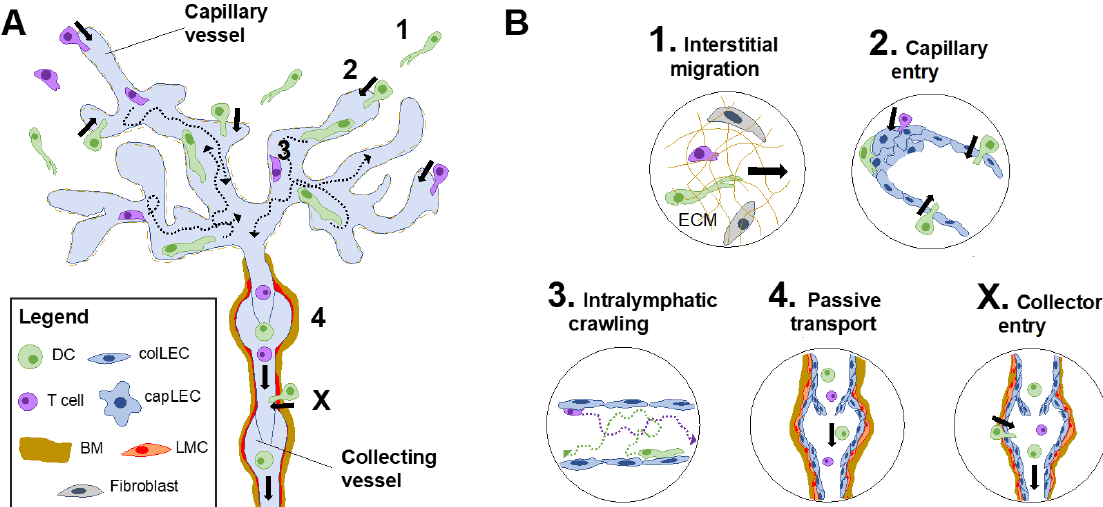
Figure 3. Leukocyte migration through afferent lymphatics occurs in a step-wise manner. ( A ) Summary of the key steps in DC and T cell migration from peripheral tissues through afferent LVs. ( B ) Description of the individual steps. Step 1: Interstitial migration: The interstitial space is comprised of fibroblasts and extracellular matrix (ECM) through which DC and T cells migrate in an ameboid fashion towards initial lymphatic capillaries. Step 2: Capillary entry: Attracted by the peri-lymphatic CCL21 chemokine gradient, DCs and T cells approach blind-ended capillaries and enter through specialized flaps formed by discontinuously joint capillary LECs (capLECs). Step 3 : Intralymphatic crawling: DCs and T cells actively crawl and patrol within the capillary lumen, thereby interacting with the lymphatic endothelium. Step 4: Passive transport: migratory DCs and T cells eventually reach the downstream collecting vessels segments. Here, lymph flow increases due to vessel contractions mediated by the collector-surrounding lymphatic muscle cells (LMCs), leading to the detachment of leukocytes and their passive and rapid transport towards the dLN. X : Shortcut into afferent LVs: Under inflammatory conditions, DCs can additionally transmigrate and directly enter into lymphatic collectors